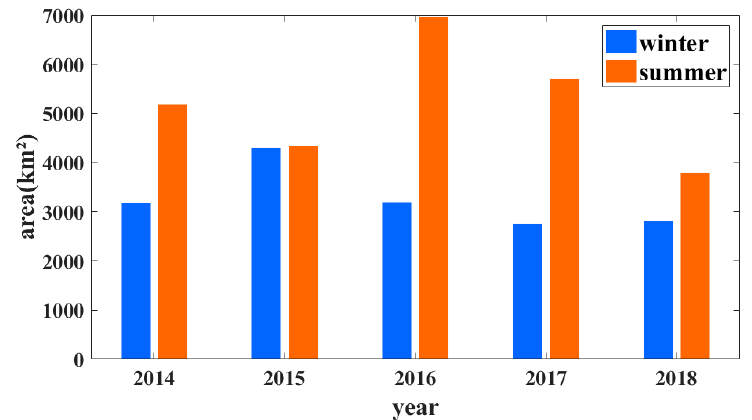
Figure 10. Statistics on the change of water area in summer and winter from 2014 to 2018 in Poyang Lake area, derived from GF-1 images.